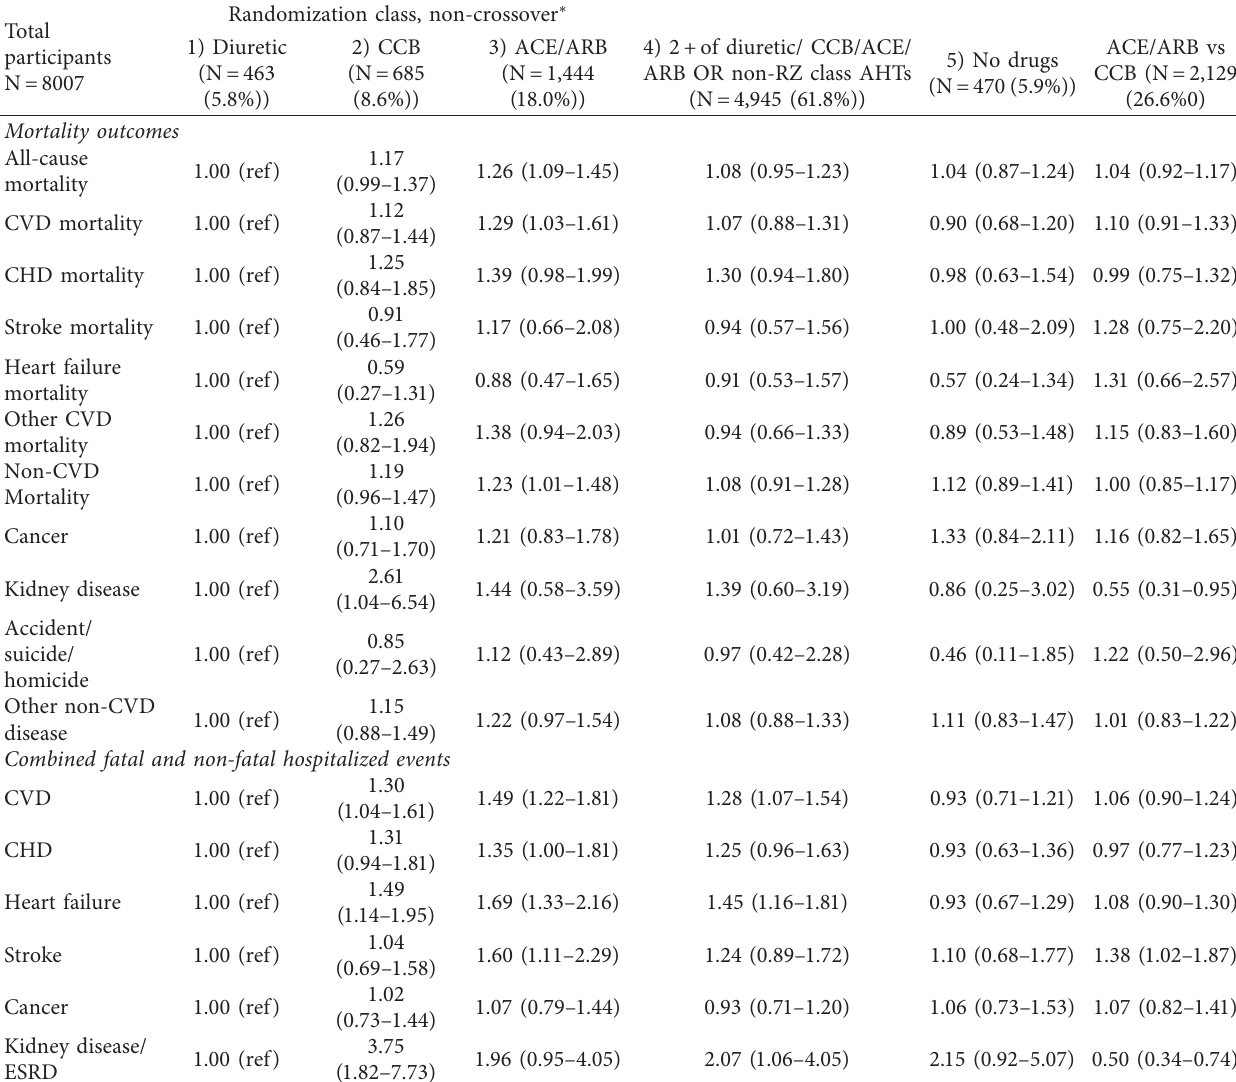
Table 4: Adjusted hazard ratio (95% CI) of morbidity and mortality by the end of posttrial (12-31-2017)